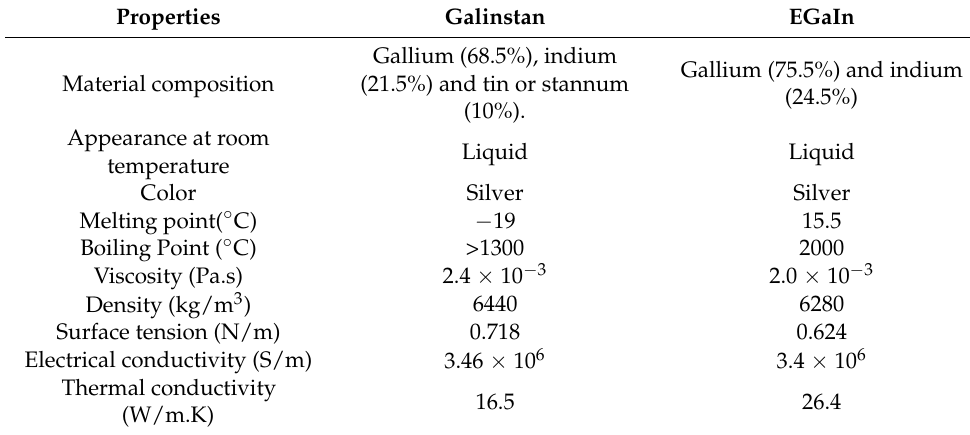
Table 1. Summary of the properties of Galinstan and EGaIn, adapted from